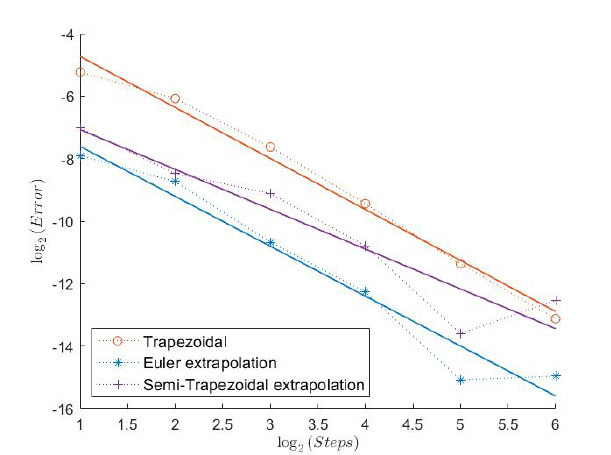
Figure 12. Indicator Model 2.